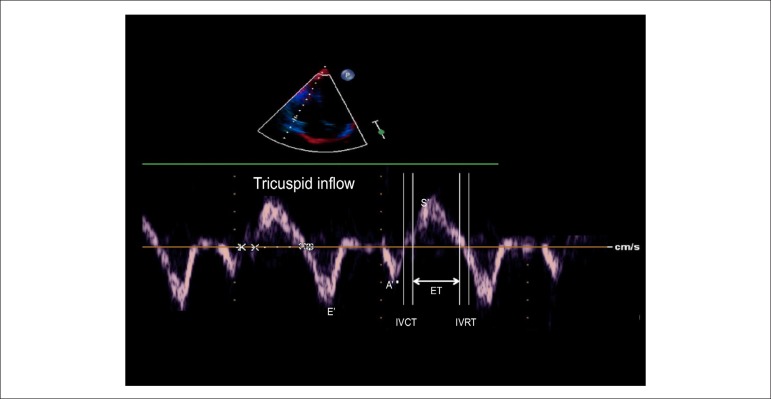
Tissue Doppler imaging performed at tricuspid annulus in apical
4-chamber view (E'- peak early diastolic annular tricuspid velocity;
A': peak late diastolic annular tricuspid velocity; S': systolic
annular velocity; IVRT: isovolumetric relaxation time; IVCT:
isovolumetric contraction time; ET: ejection time)